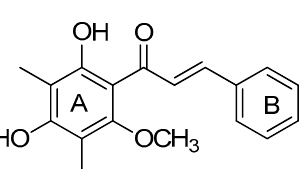
Figure 1. The structure of 2 (cid:48) ,4 (cid:48) -dihydroxy-6 (cid:48) -methoxy-3 (cid:48) ,5 (cid:48) -dimethylchalcone ( 3f ). Figure 1. The structure of 2 ′ ,4 ′ -dihydroxy-6 ′ -methoxy-3 ′ ,5 ′ -dimethylchalcone ( 3f ). Figure 1. The structure of 2 ′ ,4 ′ -dihydroxy-6 ′ -methoxy-3 ′ ,5 ′ -dimethylchalcone ( 3f ).